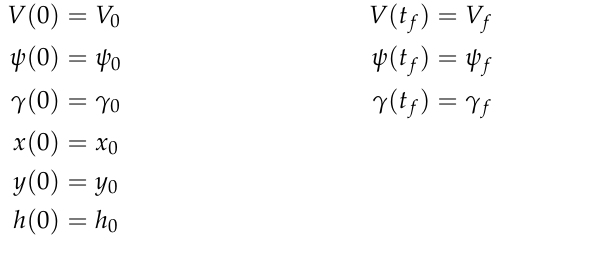
Figure 3. Horizontal wind profile shapes, with W max